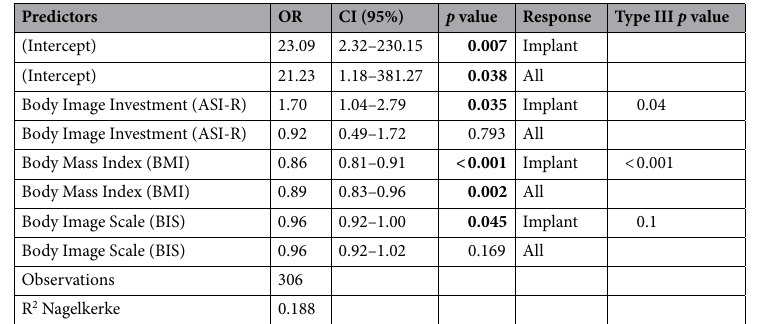
Table 2. Multivariable multinomial logistic regression model. The reference group was patients who responded that they remembered tissue-based options only. R 2 Nagelkerke is one type of pseudo R 2 used as goodness-of-fit measure. OR odds ratio; CI confidence interval. Significant values are in